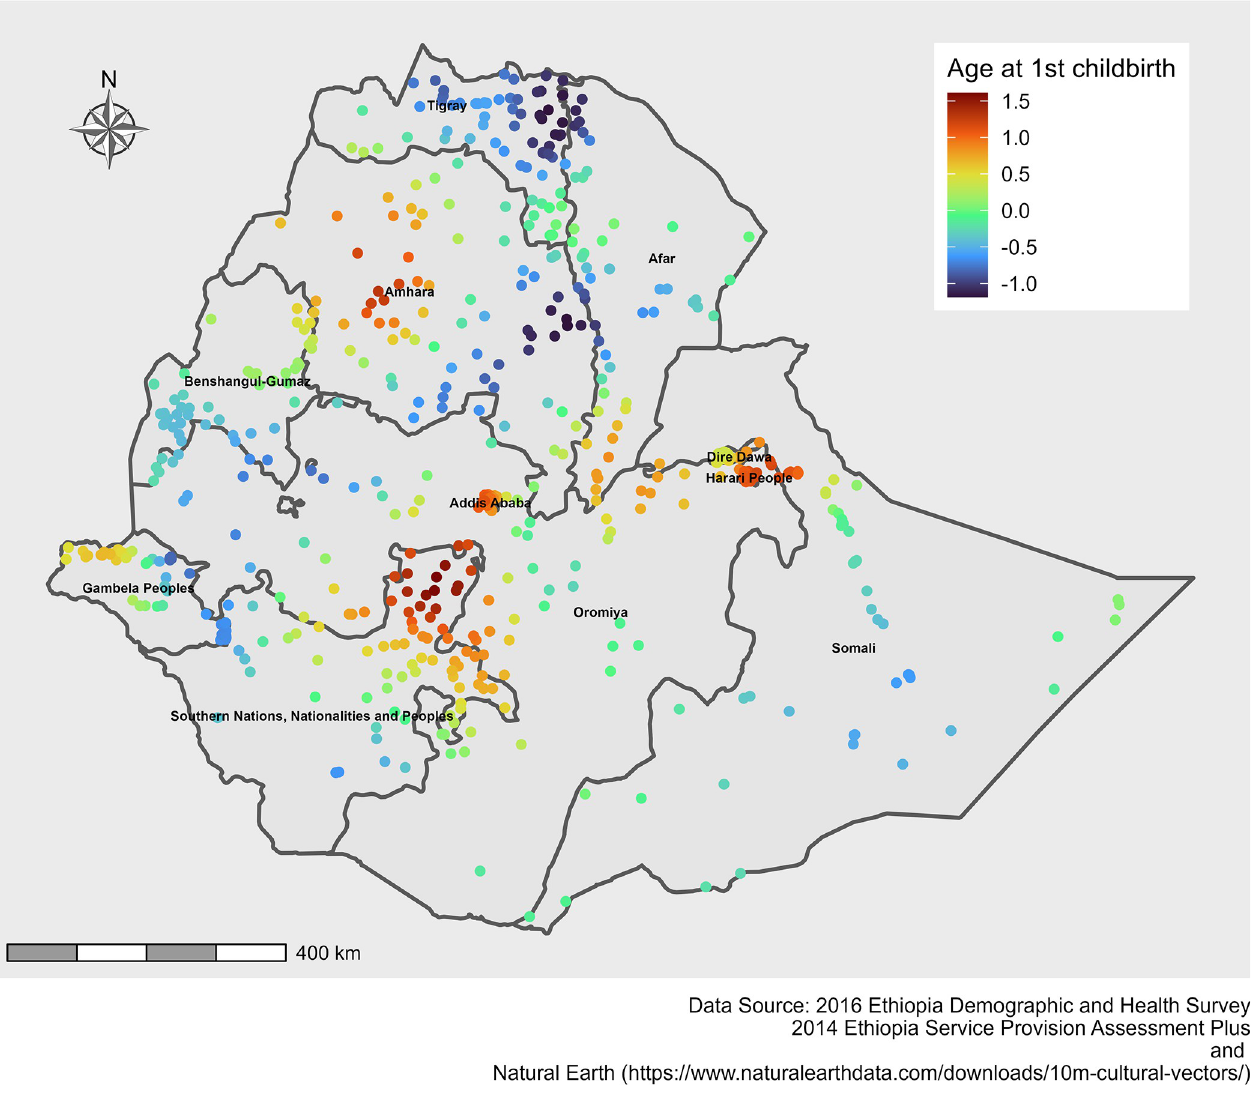
Fig 6. Spatial variations of caesarean delivery use with spatially varying coefficients of age at first childbirth in Ethiopia, 2016.